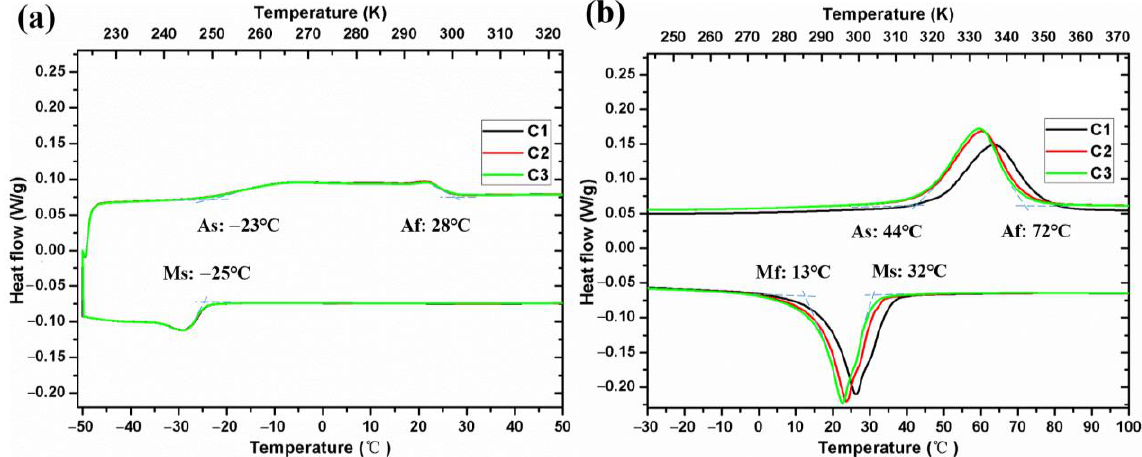
Figure 7. DSC results of ( a ) Ti 43 Ni 33 Hf 10.5 Cu 11 Nb 2.5 sample shows low M s (251 K), board transformation peak (50 K) and good thermal cycle stability (three cycles overlapped); ( b ) Ti 44 Ni 34 Hf 10 Cu 10 Nb 2 sample shows high M s (305 K), narrow transformation peak (30 K) and weak thermal cycle stability.